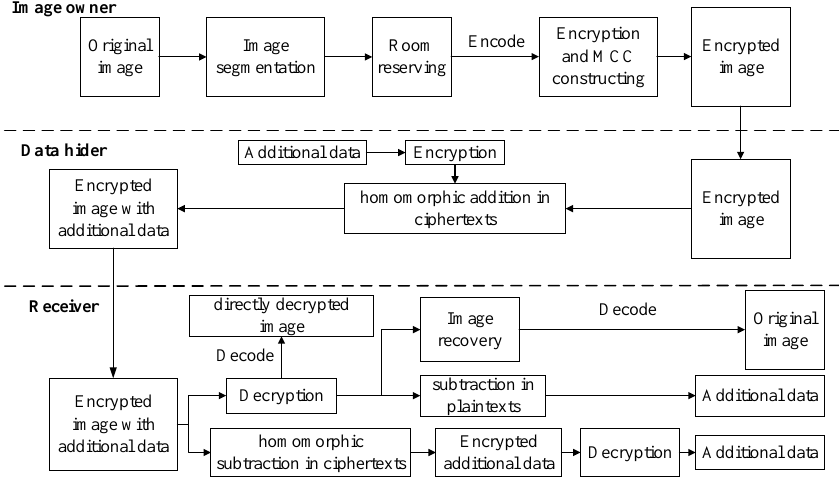
Figure 3. Overall framework of the proposed